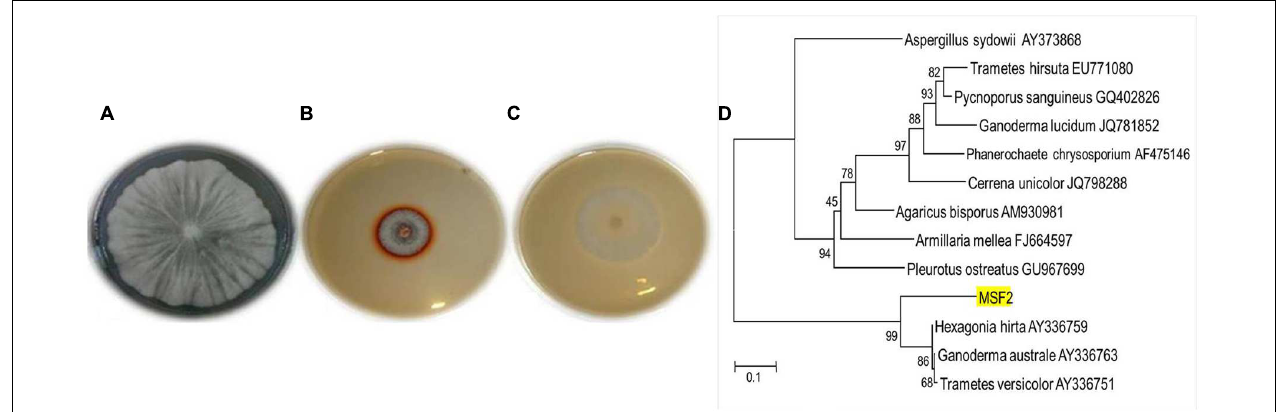
FIGURE 1 | Morphology, plate screening and identification of MSF2 (A) morphology of fungal isolate MSF2, (B) guaiacol oxidation in PDA medium and (C) PDA medium without guaiacol. Reddish brown colouration due to oxidation by MSF2 in medium containing guaiacol under culture conditions at 30 ◦ C. (D) Phylogenetic relationship of isolate MSF2 and related species based on 18 S rRNA sequences. The numbers are accession numbers of 18 S rRNA sequences. Bootstrap values at nodes are percentage of 1,000 replicates. Scale bar indicates base substitutions/100 bases.